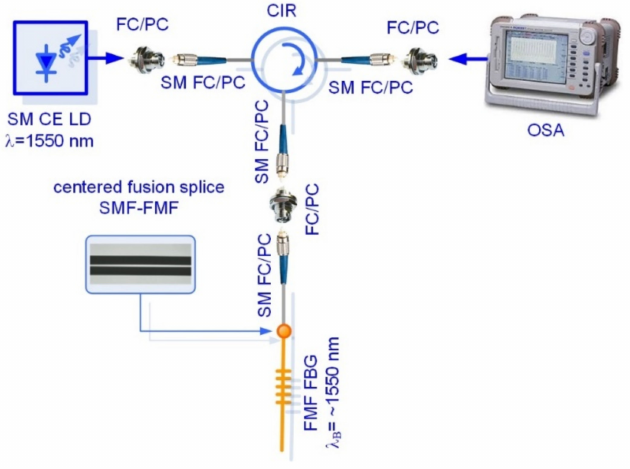
Figure 8. Conventional setup for reflected FBG spectral response measurement: testing of FBG, written on FMF under laser-based few-mode operation.